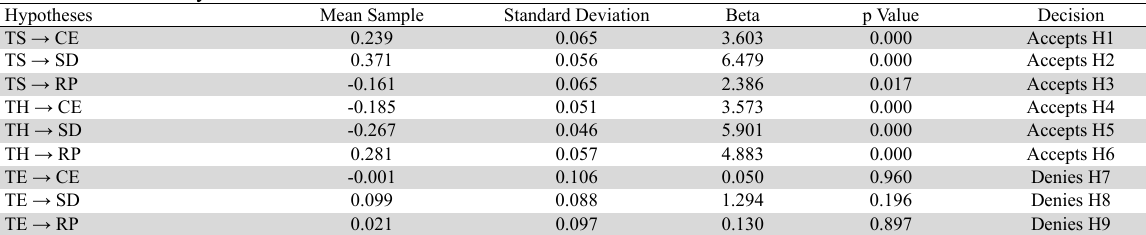
Model Structure Analysis